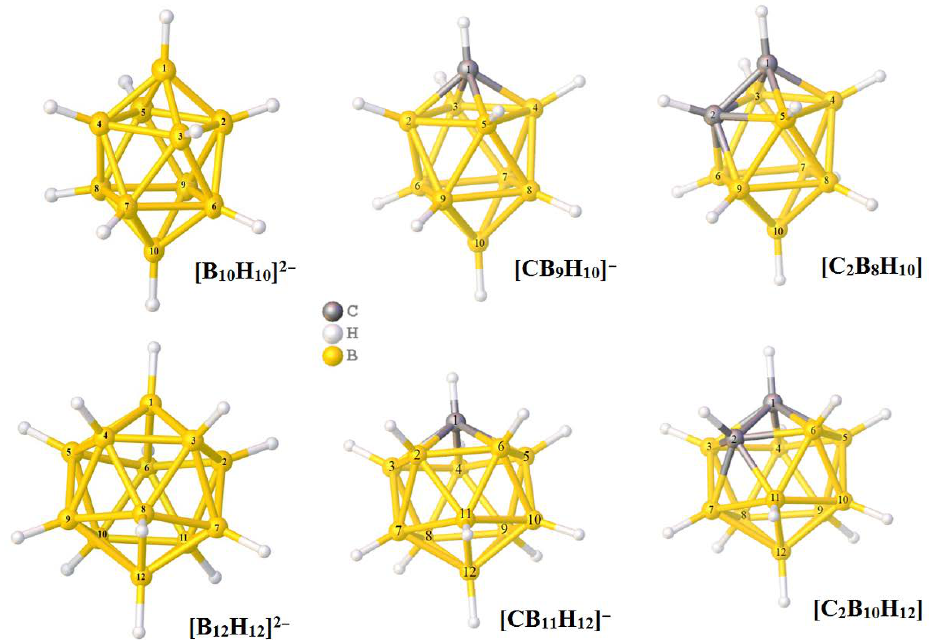
Figure 1. Structures of closo -decaborates anions, 1-carba- closo -borates anions and 1,2-dicarba- closo - boranes.